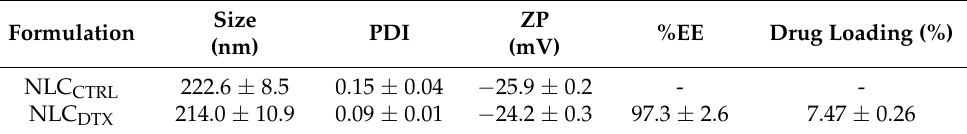
Table 1. Characterization of NLC formulations with (NLC DTX ) and without DTX (NLC CTRL ) in terms of size, polydispersity index (PDI), zeta potential (ZP), encapsulation efficiency (%EE) and drug loading